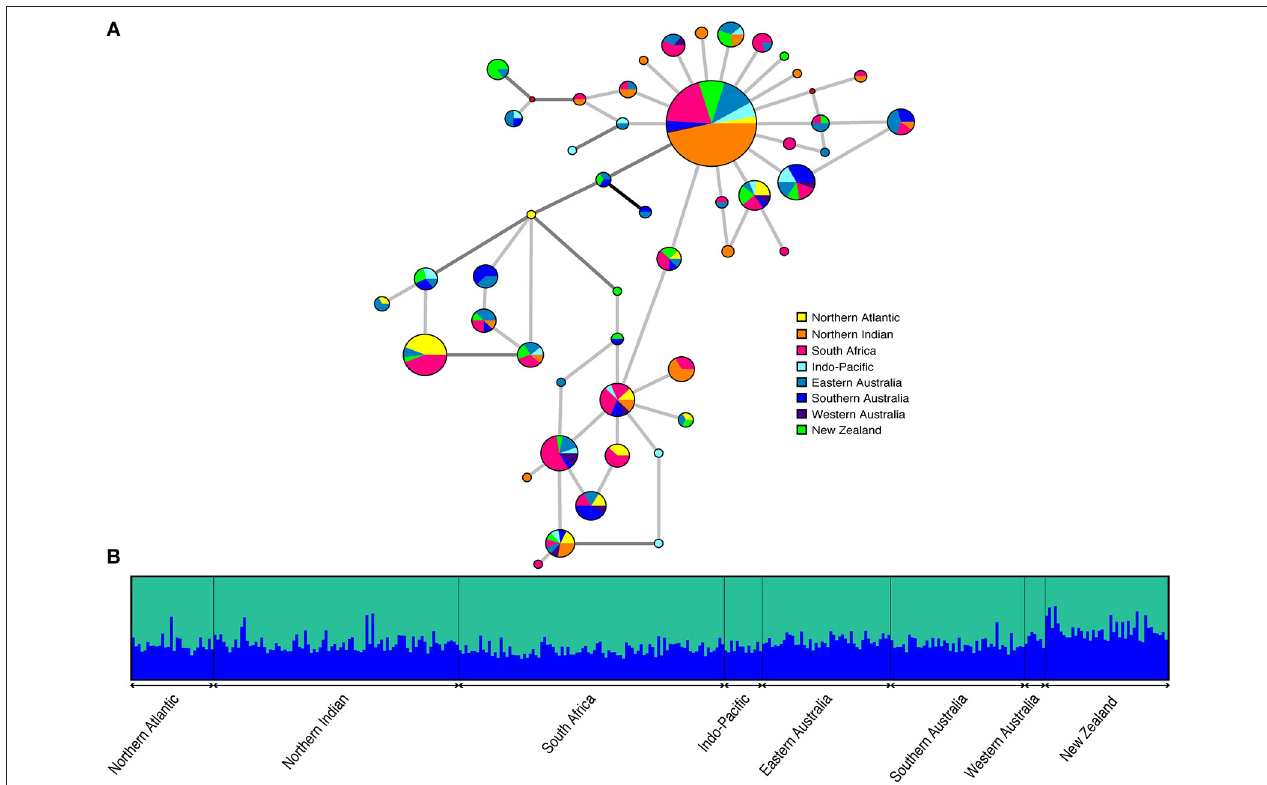
FIGURE 3 | (A) Median joining network containing 10 equally parsimonious trees. Haplotypes are shown as pie charts indicating geographical distribution with size proportional to observed haplotype frequency. Small solid red circles are intermediate states that were not observed. Light gray, dark gray, and black lines represent 1, 2, and 3 mutational steps between haplotypes, respectively (B) Plot of the estimated membership coefficients for each individual in each of two genetic clusters ( K = 2). Individuals are represented by vertical columns and grouped according to sampling